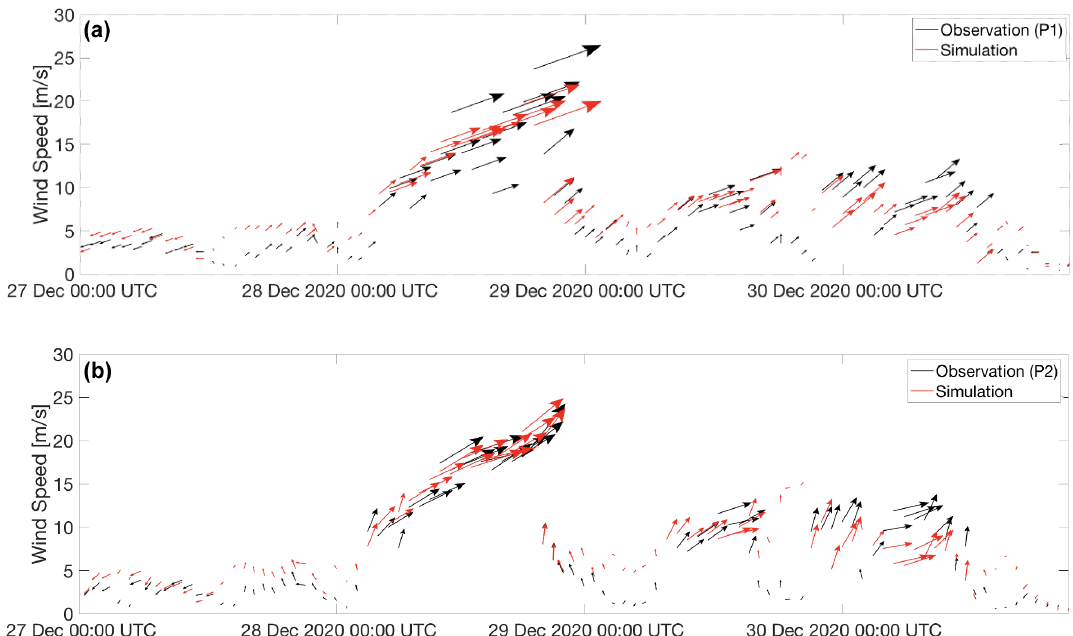
Figure 7. Comparison of in situ observations of wind speed and direction at p01 (a) and p02 (b) with the simulation results.